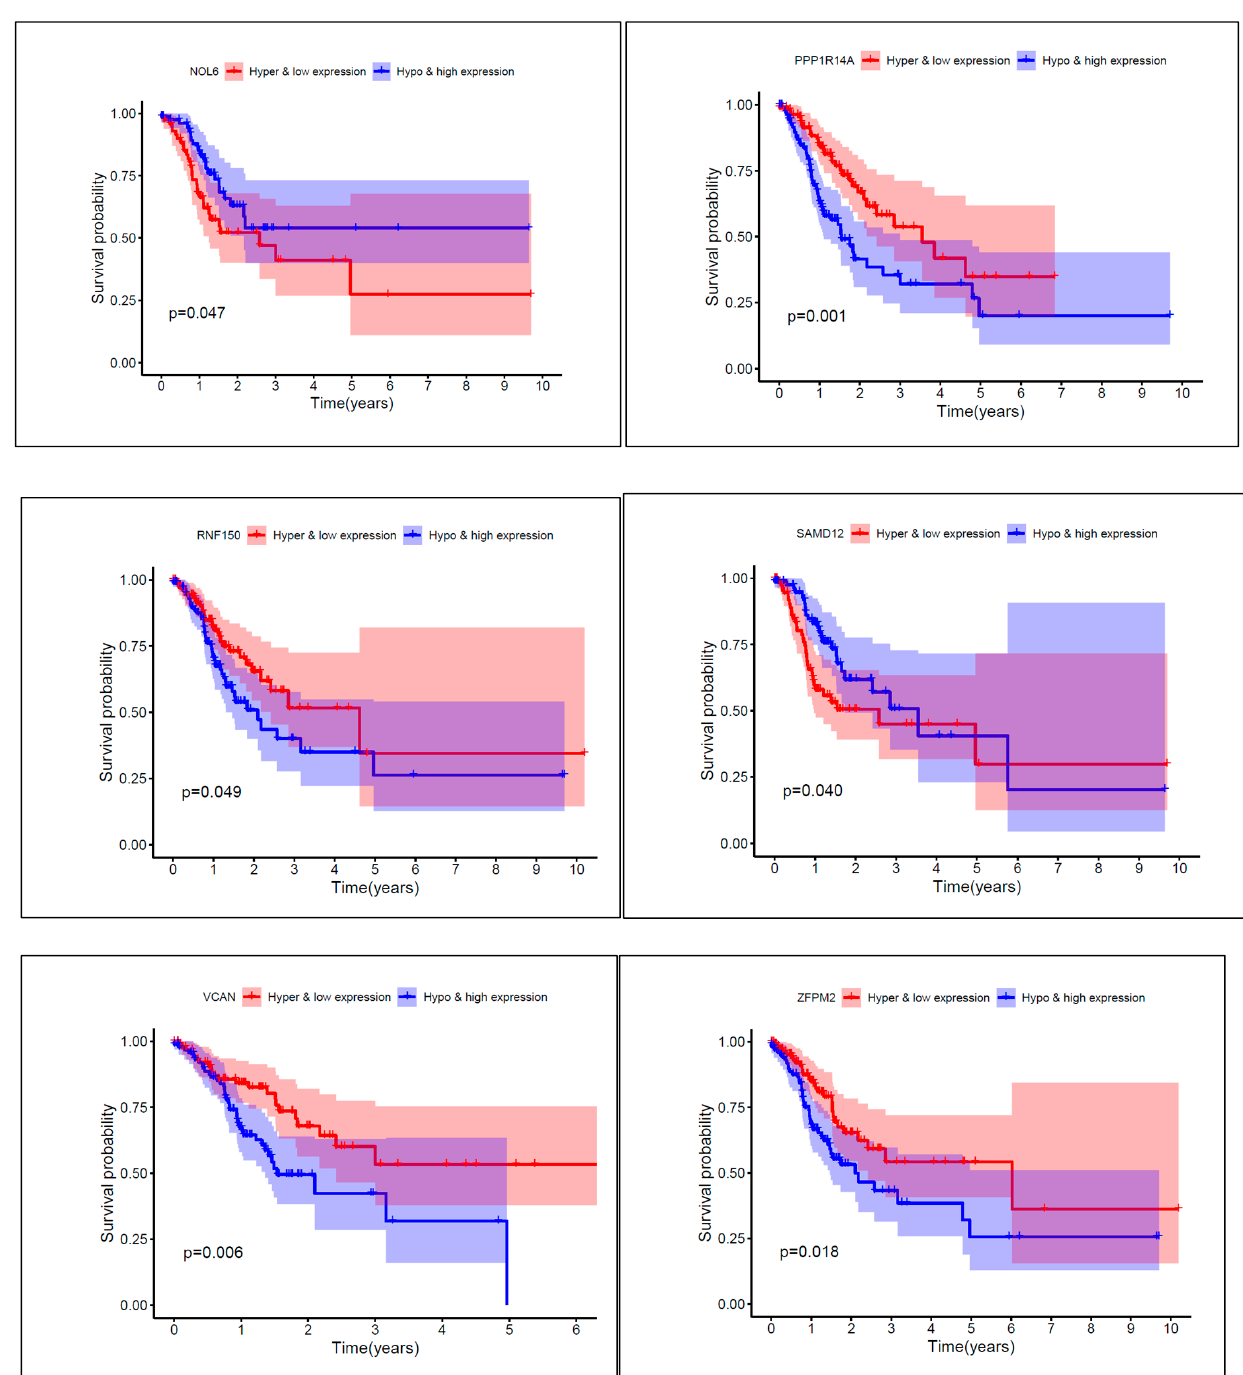
Figure 9. Prognosis survival curves of eight different expressed methylation sites.